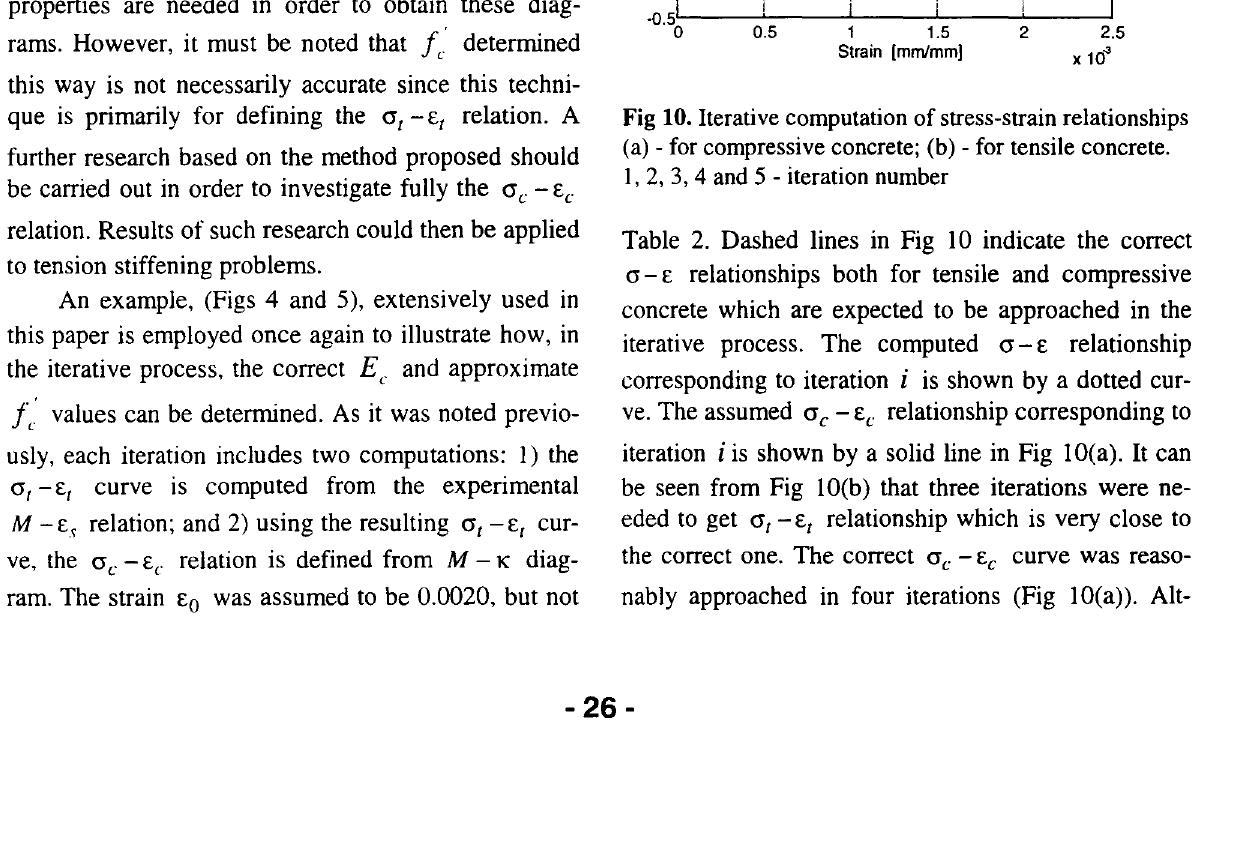
Fig 9. Assumed cr c - Ec curves for cases I, 2a and 3a Since for correctly assumed values of Ec, good accuracy is achieved even for the limiting values Eo of 0.0015 and 0.0027, Eo can be eliminated as unknown and an average value within the interval 0.0020-0.0022 assumed. With Ec and Eo known, the compressive f; strength can be obtained from Eq (6b ).